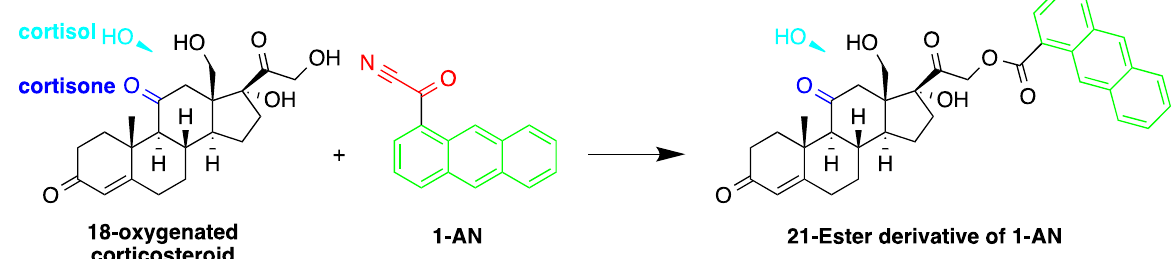
Figure 6. Fluorescent derivatization of 18-oxygenated corticosteroids by or 1-anthroyl nitrile (1-AN). Fluorescent derivatization of corticosteroids can also be carried out using dansyl hydrazine targeting the carbonyl groups (Figure 7). In a study to determine corticosteroids in human plasma and urine samples were derivatized by dansyl hydrazine and quantified by HPLC-FLD, following extraction with methylene chloride. The linearity range of the method was between 0.5 and 60 ng of cortisol, proving it to be suitable for the routine analysis of cortisol in plasma and urine [71].